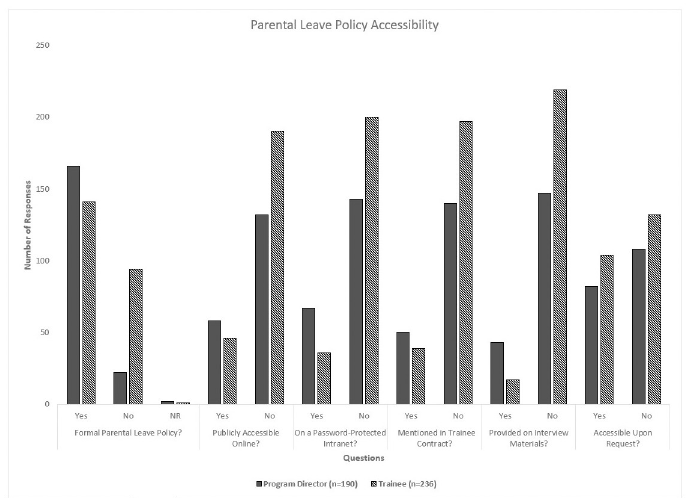
Fig 1. Responses on accessibility of parental leave